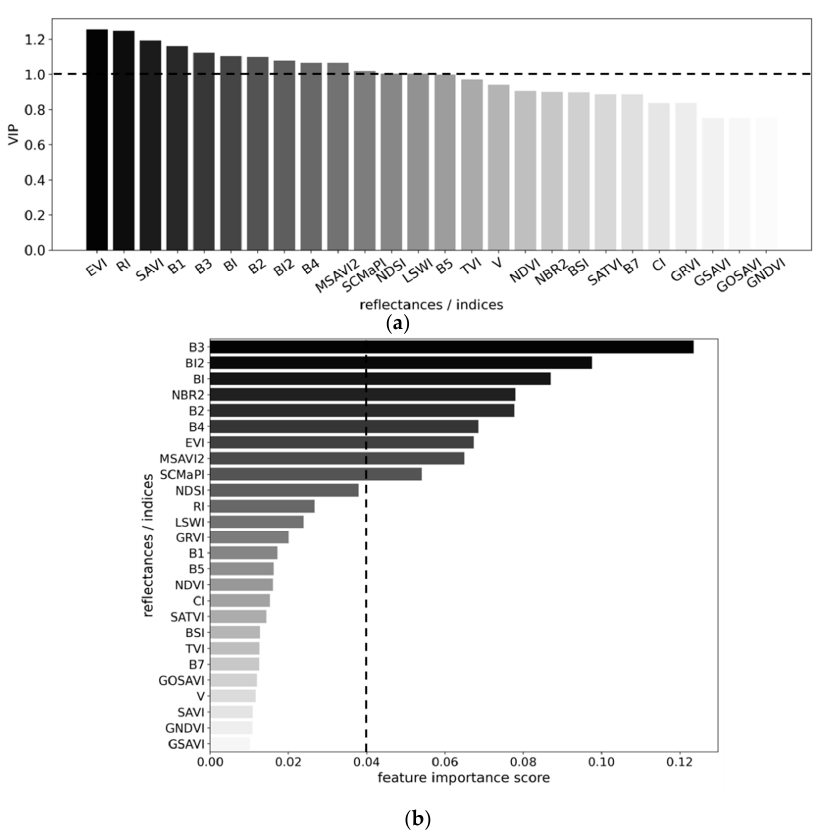
Figure 7. Feature selection for RF and PLSR. ( a ) VIP diagram of the PLSR to select the relevant features for the PLSR RI_sel run. Features with a VIP score higher than 1.0 are selected for the RI_sel database. ( b ) The feature importance score for the RF selection of relevant features. Features with a score higher 0.04 (4%) are selected for the RI_sel database.